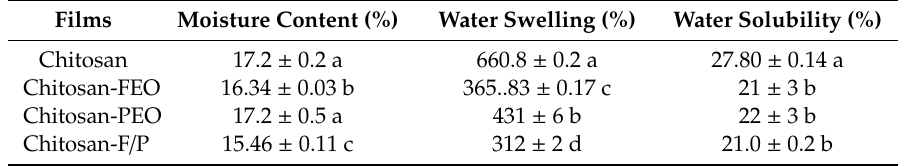
Table 2. Moisture content, water swelling, and solubility of Chitosan, Chitosan-FEO, Chitosan-PEO, and Chitosan-F / P films.